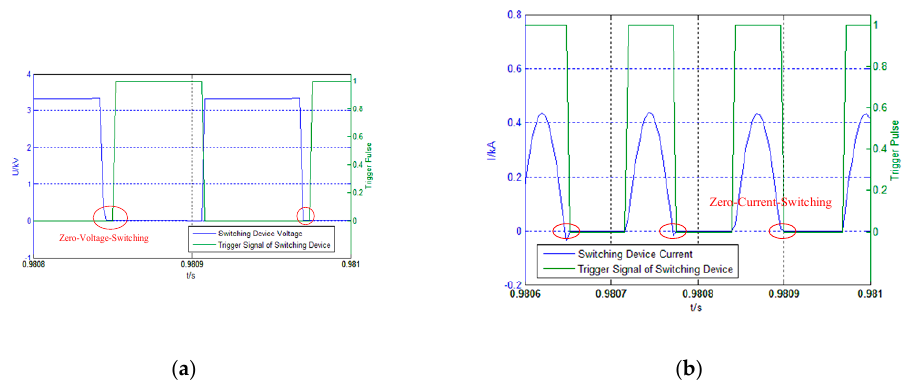
Figure 11. The steady-state working waveform of the CLLC: ( a ) the zero-voltage-switching waveform of the primary-side switching device; ( b ) the zero-current-switching waveform of the secondary-side switching device.